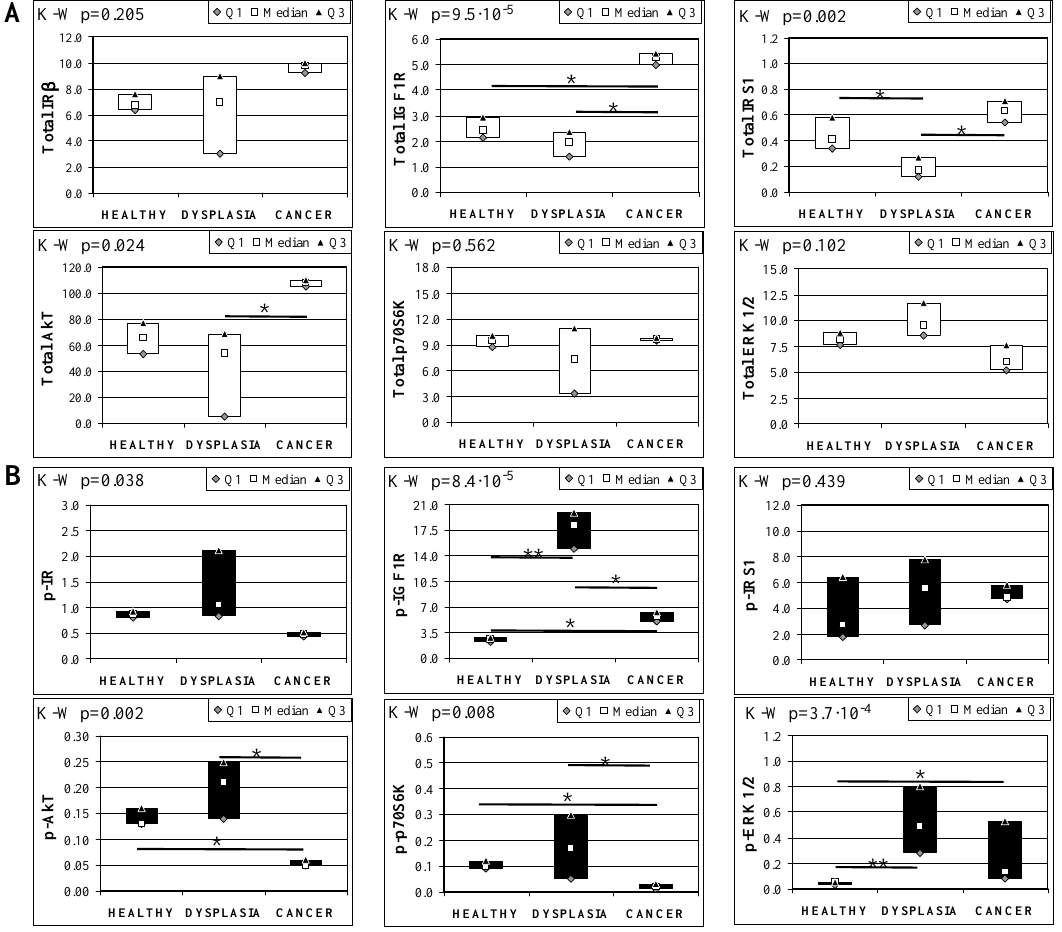
Figure 2. Insulin signaling in operated WT female mice esophageal tissue. Data are represented as Median (Q1; Q3). Data obtained in operated mice affected by dysplasia or cancer were compared to strain-, sex-, and age-matched, non-operated animals (43 weeks). K-W indicates the Kruskal-Wallis test result, used for multiple comparisons among the three groups of mice. The Mann-Whitney U-test was performed to compare data distribution between two groups of mice. After correction a A p -value lower than 0.016 (Bonferroni adjustment) was considered statistically significant: * p < 0.016; ** p < 1.6 × 10 − 3